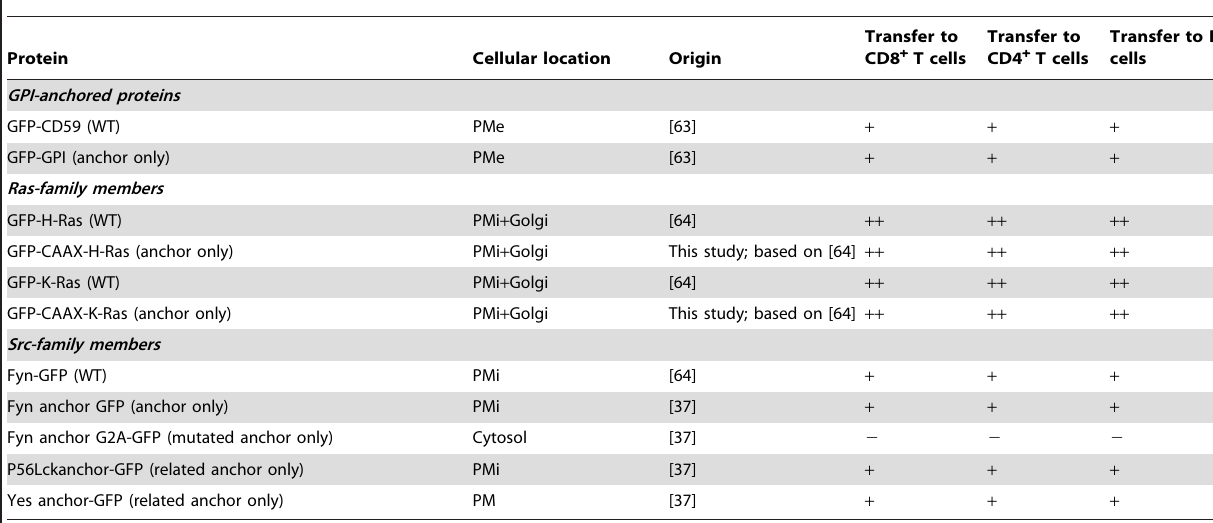
Table 2. Impact of PM anchors on the transfer efficiency of fluorescent proteins.